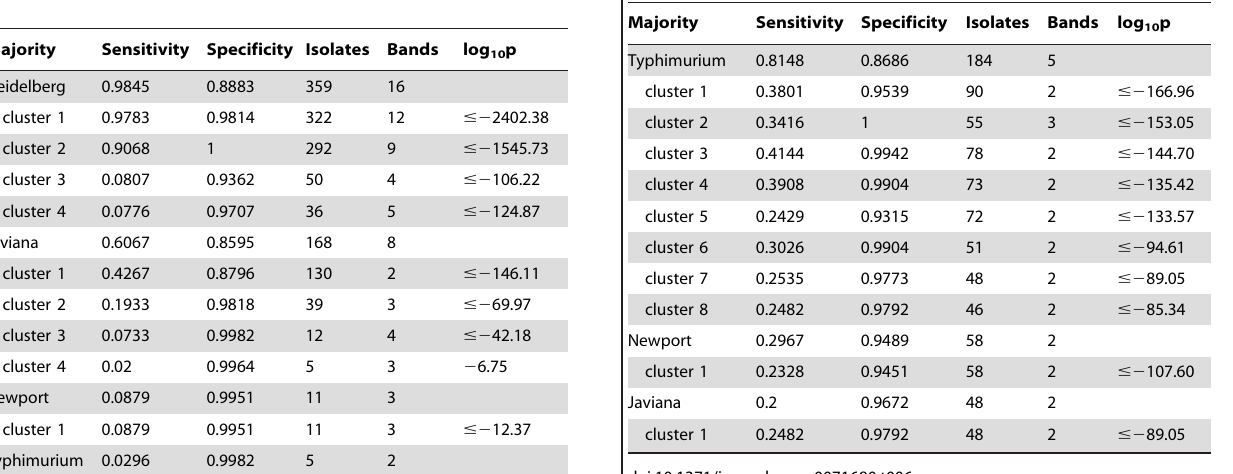
Table 6. The ten largest biclusters identified by